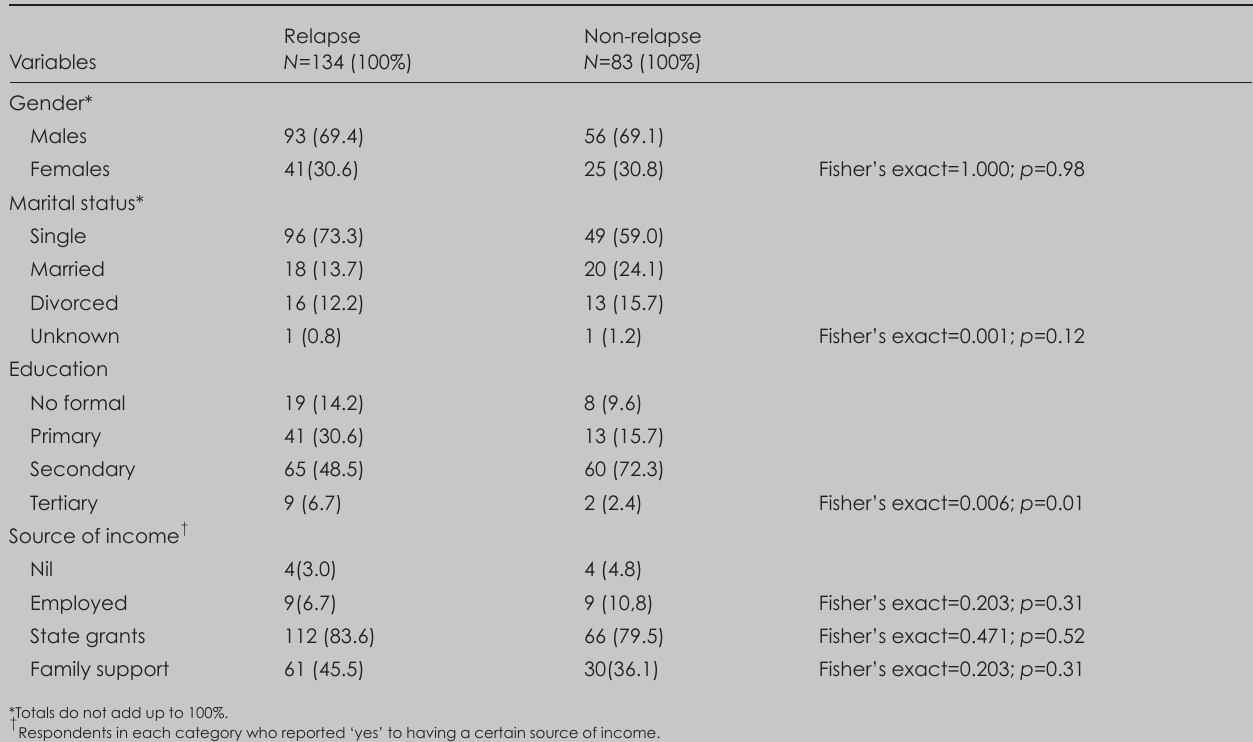
Table I. Demographic characteristics of the study